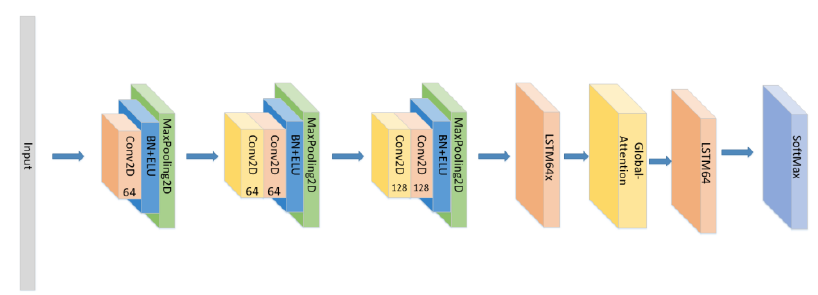
Figure 7. The construction of the CNN+LSTM+Global-Attention+LSTM model.